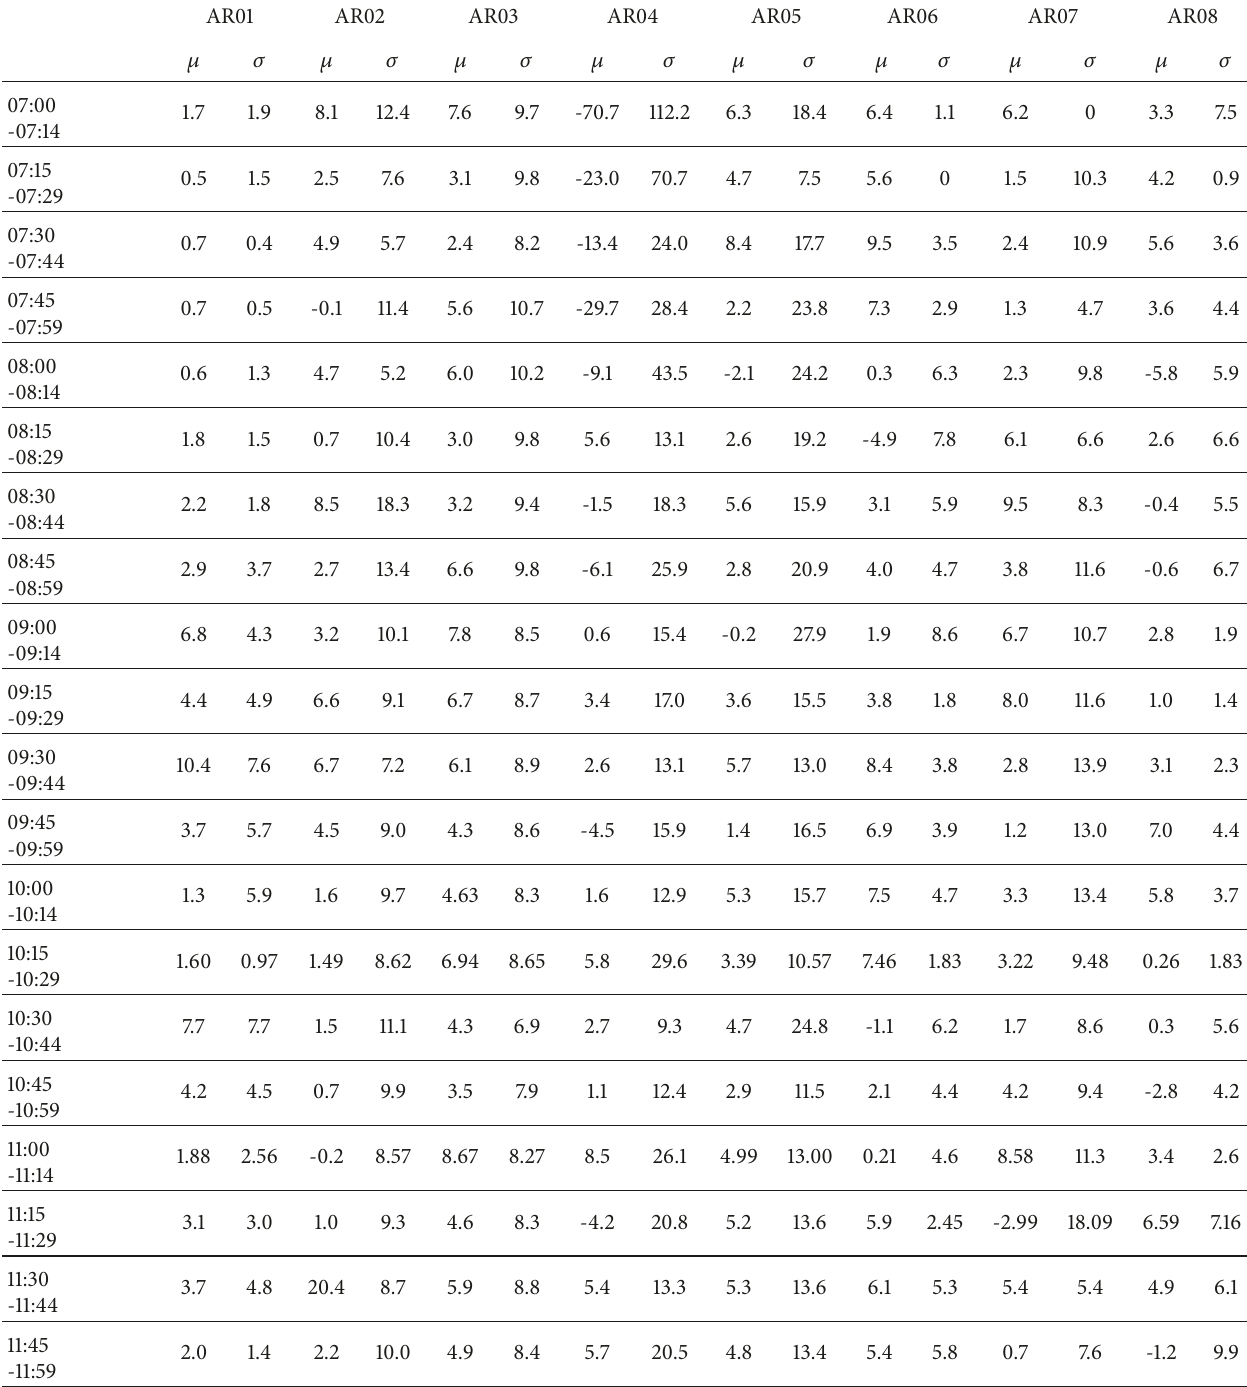
Table 1: Mean 𝜇 and variance 𝜎 of aircraft’s predicted time error Δ𝑡 𝑖𝑛 𝑖 of entering sector AR01-AR08